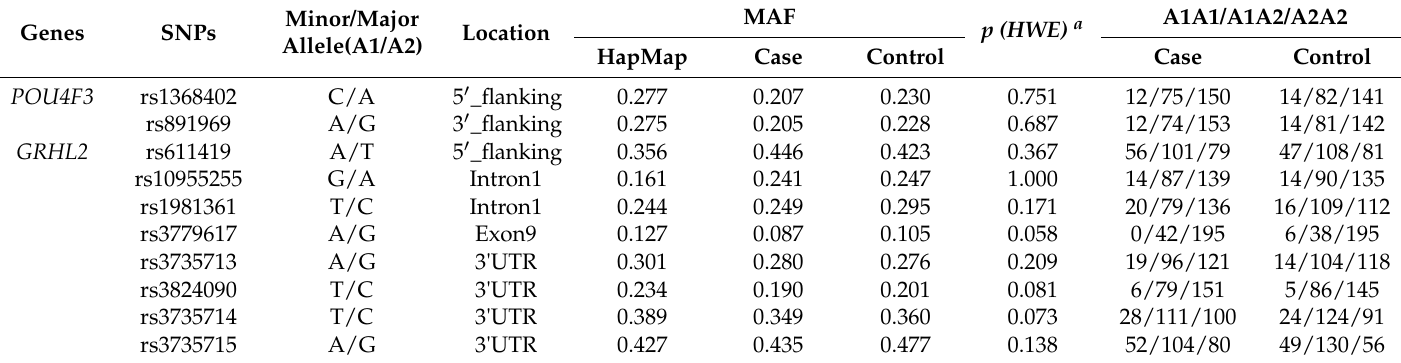
Table 1. Basic information of the 10 SNPs in POU4F3 and GRHL2